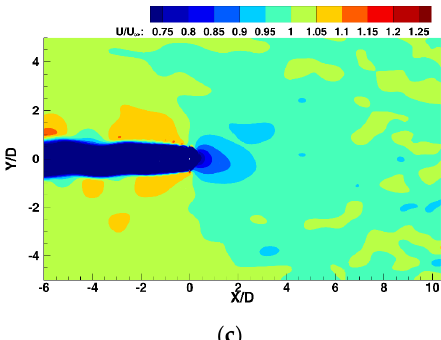
Figure 8. ( a ) Effect of update frequency on the average wind velocity upstream of VAWT; ( b ) Snapshots of flow field upstream of VAWT for Randomisation Update Frequency = 360 time-steps; ( c ) Snapshots of flow field upstream of VAWT for Randomisation Update Frequency = 45 time-steps.